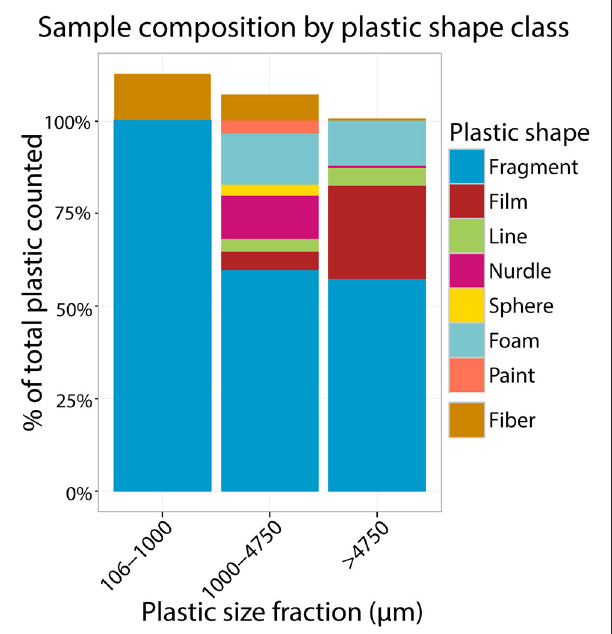
FIGURE 6 | Stacked barplot depicting the relative abundance of different shape classes amongst plastic from each size fraction. The bar to 100% for each size class represent the relative abundance of different shape classes when fibers were not included in the total counts and the portion above 100% represents the relative abundance of fibers in the total